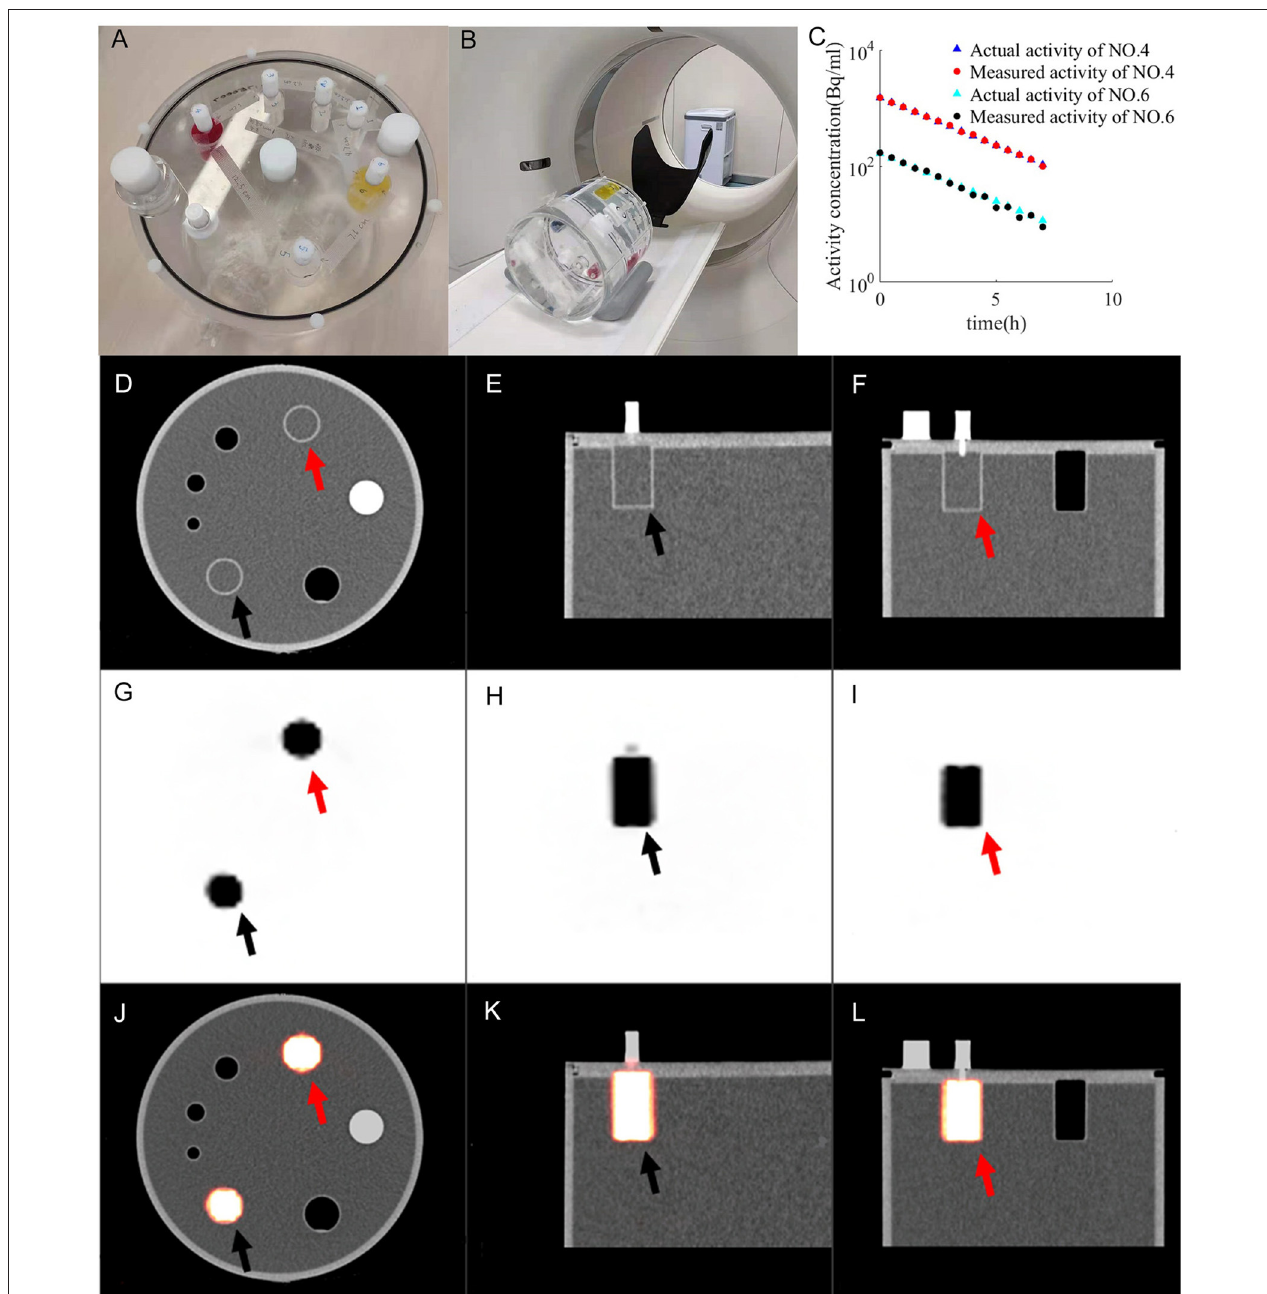
FIGURE 1 | Imaging of PET validation phantom (A) under PET/CT (B) . CT images (D–F) and PET images (G–I) form fused images (J–L) . The activity of container 4 (red arrow) and container 6 (black arrow) changes with time (C) . R actu of container 4 (blue triangle), R meas of container 4 (red dot), R actu of container 6 (green triangles), R _ meas of container 6 (black dot) are distributed between 11.1 and 1,480 Bq/mL.